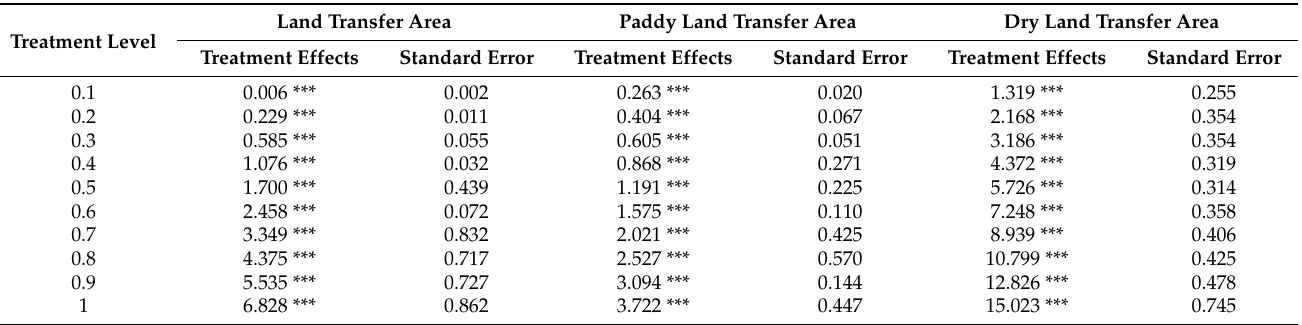
Table 7. GSPM estimation of types of land transfer area on the months of per year non-farm employment per